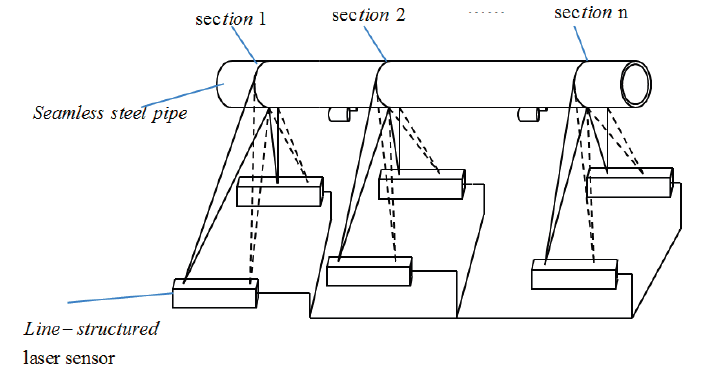
Figure 3. Sketch of the measurement system (with permission from [10]).